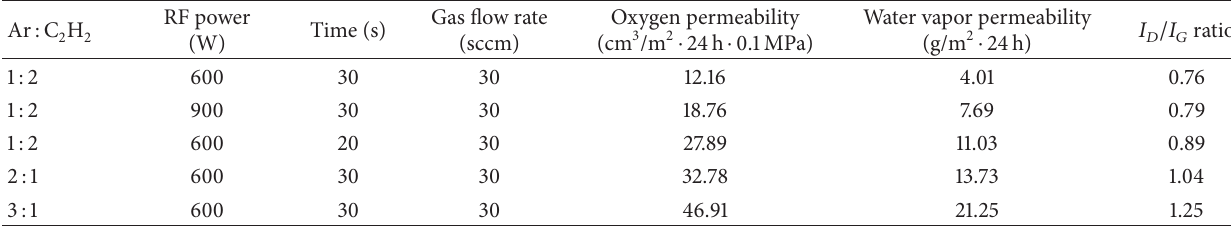
Table 2: 𝐼 𝐷 /𝐼 𝐺 ratios under different process conditions.